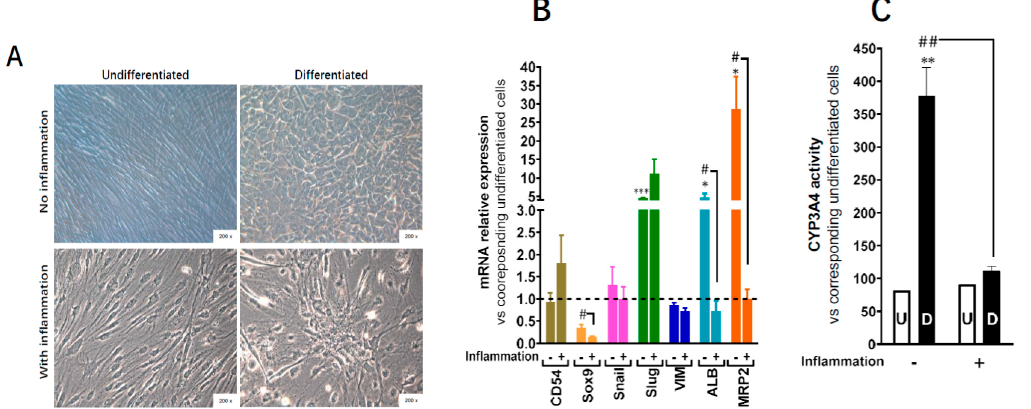
Figure 8. Effect of 30 days-inflammation on ADHLSC hepatogenic differentiation potential. ( A